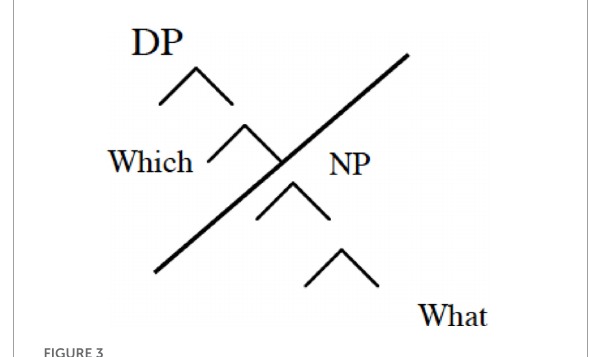
FIGURE3 A truncated structure for acquisition of Wh-